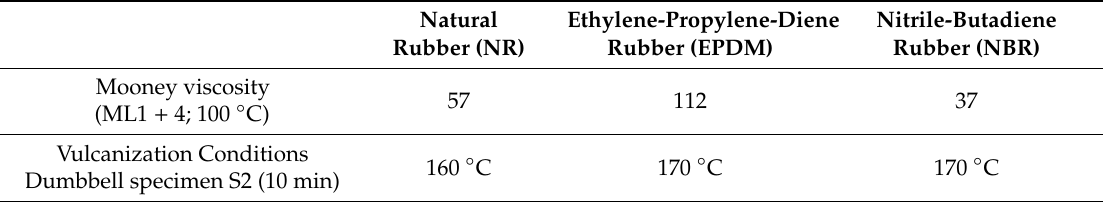
Table 1. The Mooney viscosity of the available rubbers (according to the manufacturer